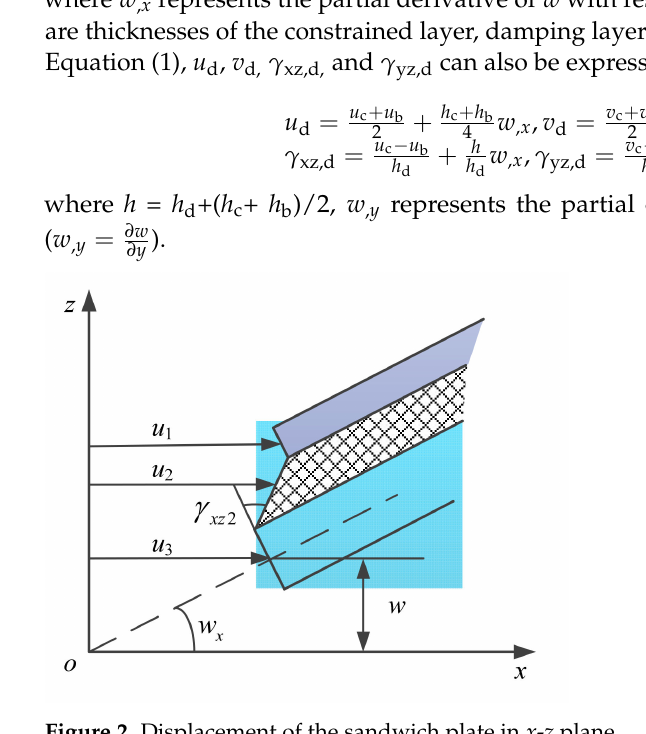
Figure 2. Displacement of the sandwich plate in x - z